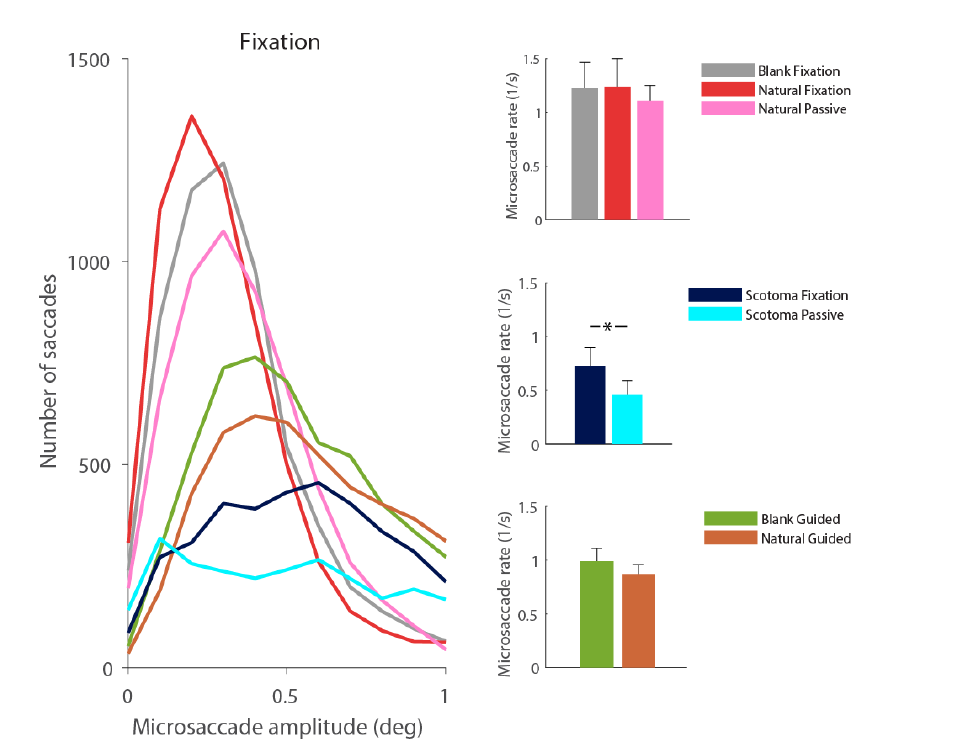
Figure 6. Effect of peripheral stimulation on microsaccades. Left panel: microsaccade amplitude distributions for each experimental condition, for all subjects combined (N=6). Right column: average saccade rate across subjects, for a selection of comparisons. Dy- namic peripheral stimulation tended to suppress microsaccades when compared to static peripheral stimulation. This was true for the fixation of a static natural scene vs. a dynamic natural scene (i.e. during passive viewing, top) for the fixation of a scotoma with a static background vs. a dynamic background (middle), or for the guided viewing of a fixation target over a blank scene vs. the guided viewing of a fixation target over a static natural scene (in which the background did not move, but large eye movements repeatedly “refreshed” the peripheral retinal input) (bottom). Significant comparisons are highlighted with an asterisk